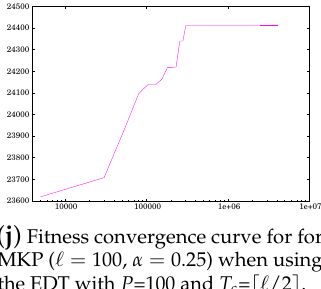
( g ) Convergence of the phenotypic values for NK-LAND ( (cid:96) = 30) when using the EDT with P =60 and T c = (cid:100) (cid:96) /8 (cid:101) .